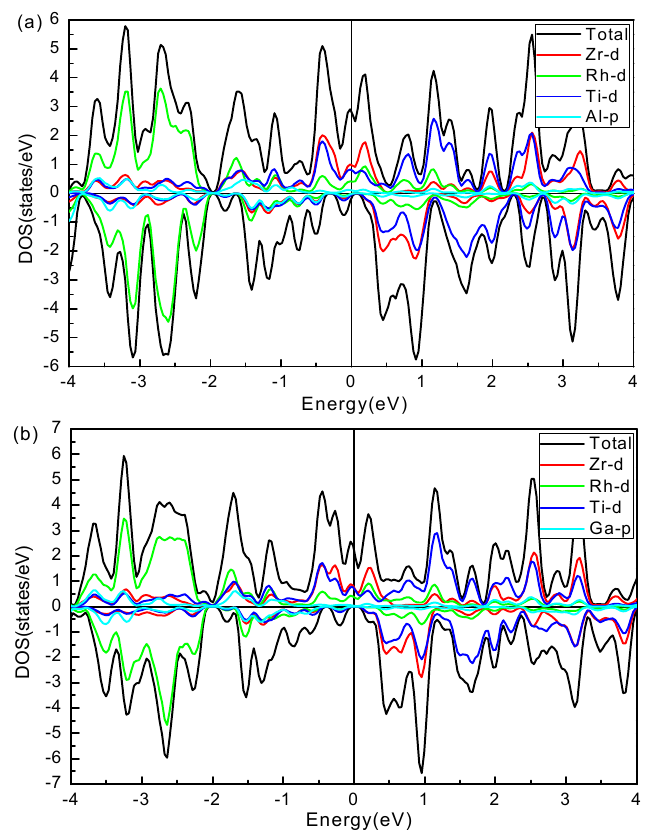
Figure 4. Calculated total density of states and partial density of states of ZrRhTiAl ( a ) and ZrRhTiGa ( b ).